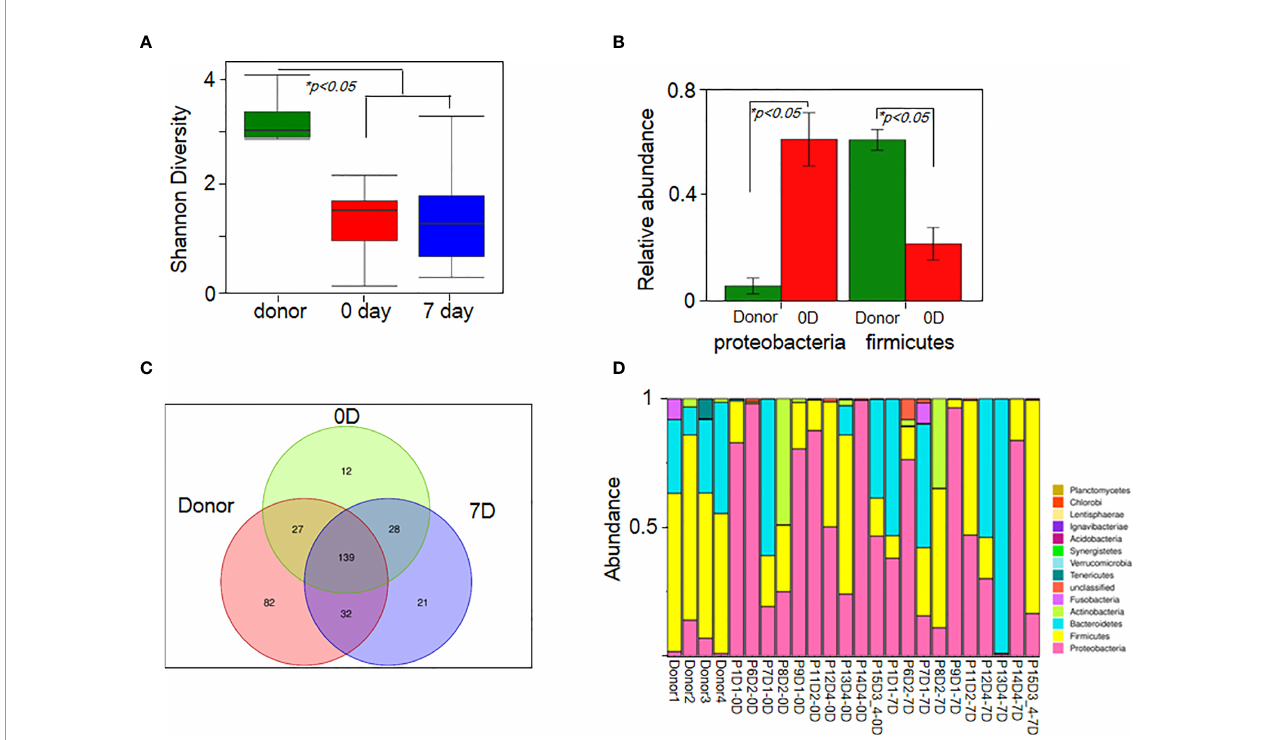
FIGURE 4 | FMT improves gut microbiota diversity and composition in patients. (A) The diversity of fecal microbiota in all sample (Shannon ’ s diversity index) (n donor =4, n patient =10). (B) Relative abundance of proteobacteria and fi rmicutes between donor and recipient. *p < 0.05. (C) OTUs change in donor group, pre-FMT (0D) and post-FMT(7D) samples. (D) Analysis of fecal microbiota composition in all samples at the phylum level(n donor =4, n patient =10). Each row represents a study subject. Px means patient number, Dx means donor number, xD means day after